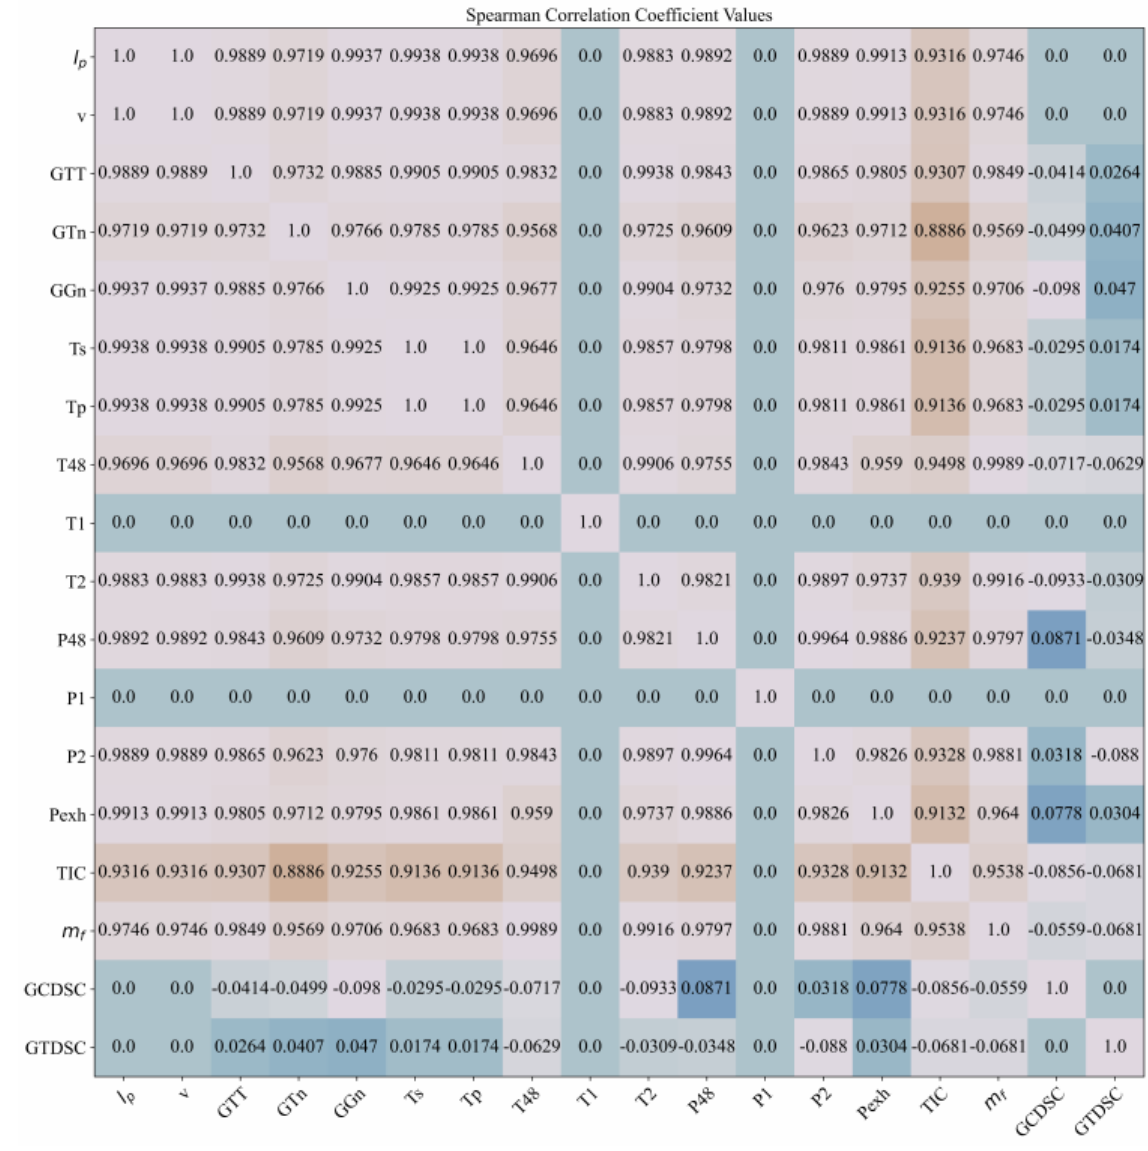
Figure 6. The result of Spearman’s correlation